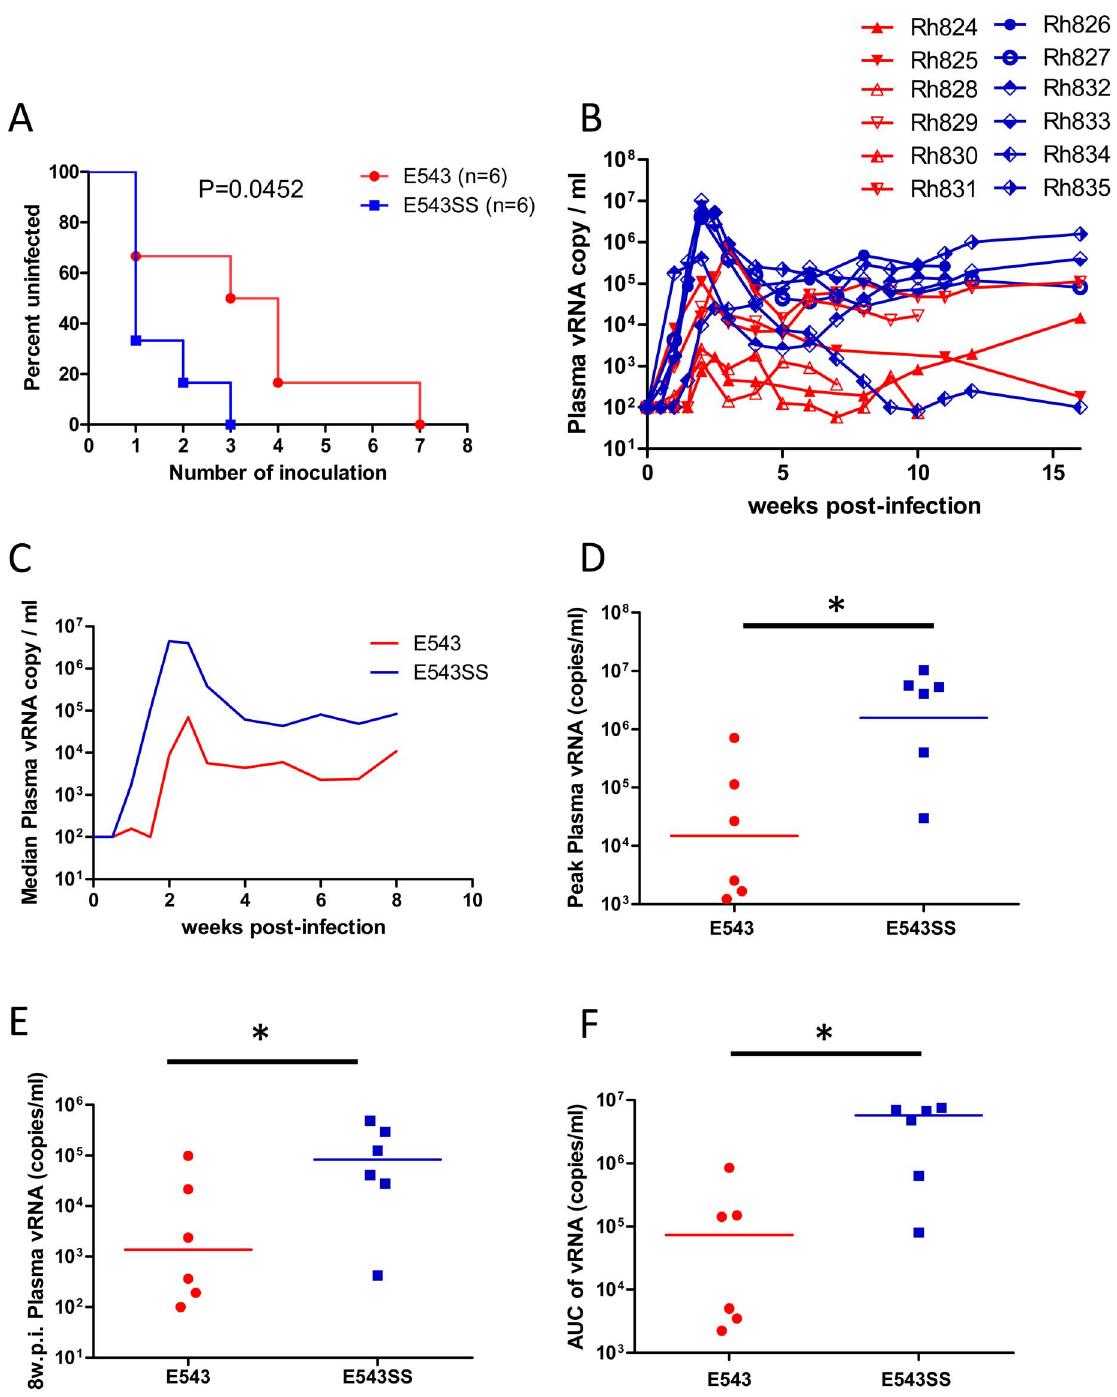
Figure 6. Acquisition and replication of SIVsmE543-3 and SIVsmE543-3 S 37 S 98 in macaques with TRIM5 TFP/TFP genotype. Each macaque was inoculated intrarectally (I.R.) with 1000 TCID 50 (5 6 10 5 RNA copies of virus) and the infection was monitored by measuring plasma viral RNA load. Four weeks later any of the macaques that remained uninfected were inoculated intrarectally on a weekly schedule with same amount of virus until they became infected. The acquisition of infection in each group was shown as uninfected percentage after each inoculation and compared by log-rank test. Median inoculation time was 3.5 for SIVsmE543-3 challenge group and 1 for SIVsmE543-3 S 37 S 98 challenge group (A). Plasma viral RNA copies in each macaque (B) and median plasma viral RNA copies in each group (C) are shown. Peak plasma viral loads (D, P=0.0152), plasma viral loads at 8 w.p.i. (E, P=0.0411) and viral load AUC before 8 w.p.i. (F, P=0.0260) were compared by non-parametric Mann-Whitney-test. doi:10.1371/journal.ppat.1003577.g006 selection occurred mainly at the time when SIV was being that evolved in macaques following experimental passage, introduced into a new primate species. When compared with including SIVmac, SIVsmm, SIVstm and SIVmne, had amino primary SIVsmm clones from sooty mangabeys, many SIV clones acid substitutions/deletions at the sites under TRIM5 selection in